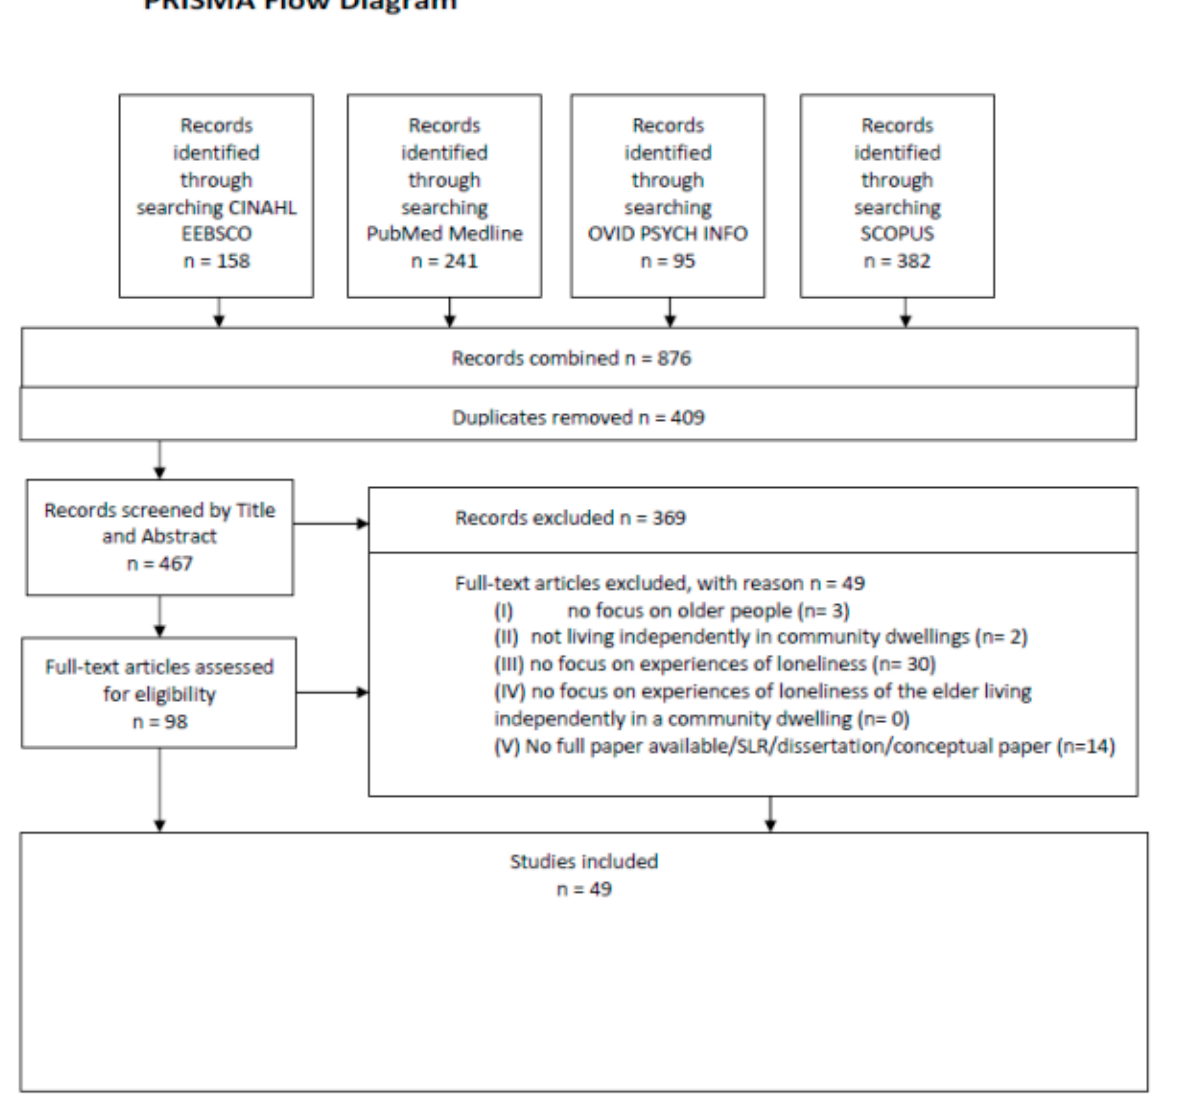
Figure 1. PRISMA flow diagram of information through different phases of the systematic review (Liberati et al. 2009).